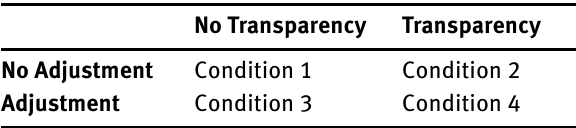
Figure 2: The layout of the room where the experiment was con- ducted. The participant is seated in the chair (green), the starting position of the robot (CoB) is represented as a blue rectangle, its final position is marked in blue; the operator was hidden behind the screen in the upper right hand corner. Table 1: The four conditions of the experiment. In all conditions the participants were provided enough information to complete the